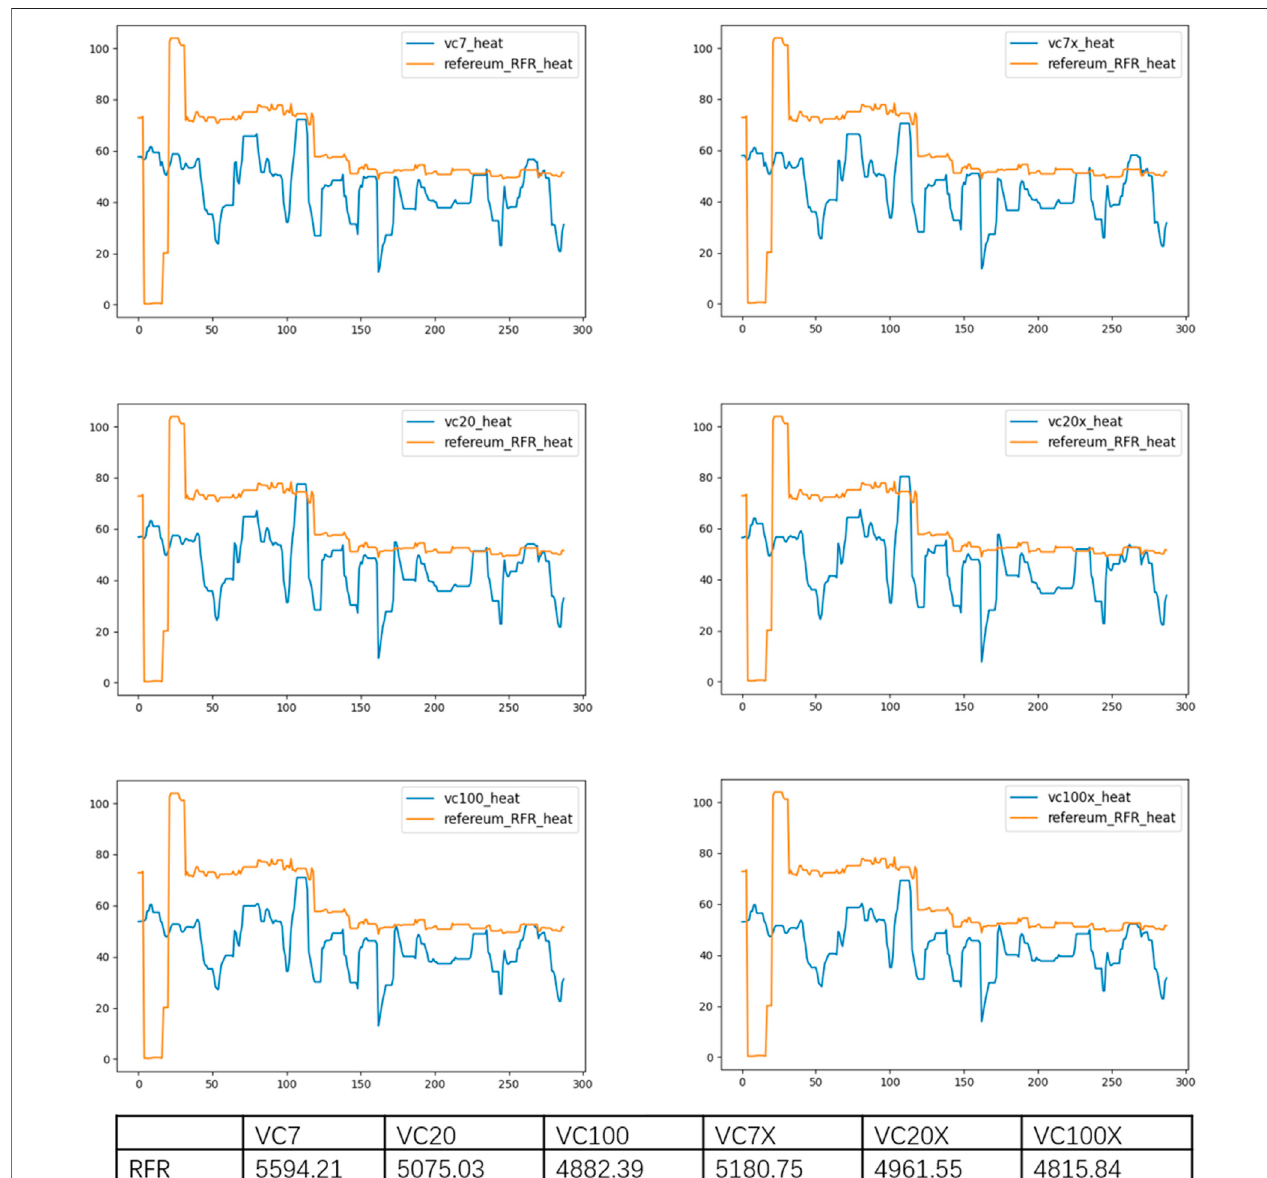
FIGURE 13 | August 3 abnormal currency RFR popularity value and six index